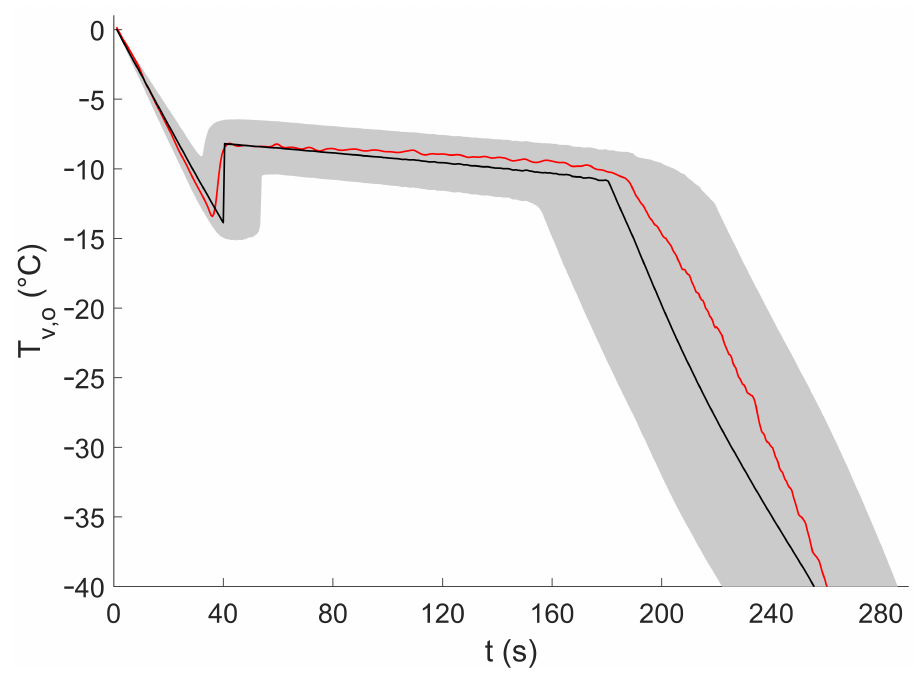
Figure 7. Uncertainty analysis of one representative outer vial wall temperature profile of the 20 imposed cooling profiles (i.e., which had liquid- and solid-phase cooling rates of 20 ◦ C/min and a crystallization phase duration of 150 s). The red solid line represents the outer vial wall temperature data from the experiment as measured by the infrared camera. The black solid line represents the model prediction of the outer vial wall temperature based on the model input pa- rameters, assuming that no uncertainty was present in the model input parameters. The gray area indicates the prediction interval of the model prediction of the outer vial wall temperature, taking the uncertainty in the model input parameters into